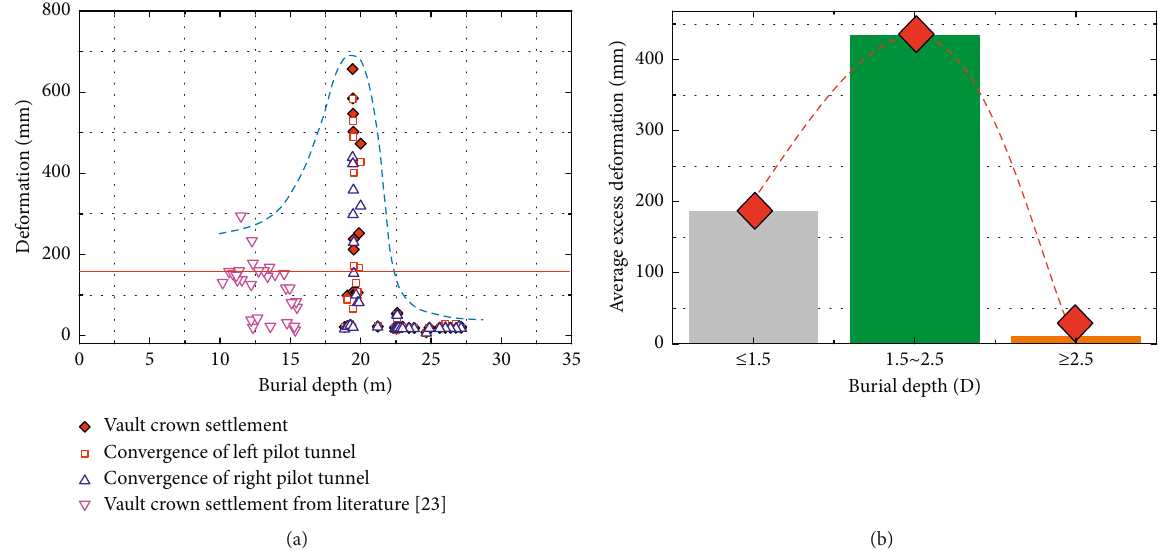
Figure 6: Distribution of deformation with burial depth: (a) distribution of the ultimate deformation value with burial depth; (b) dis- tribution of average exceeding deformation with burial depth.